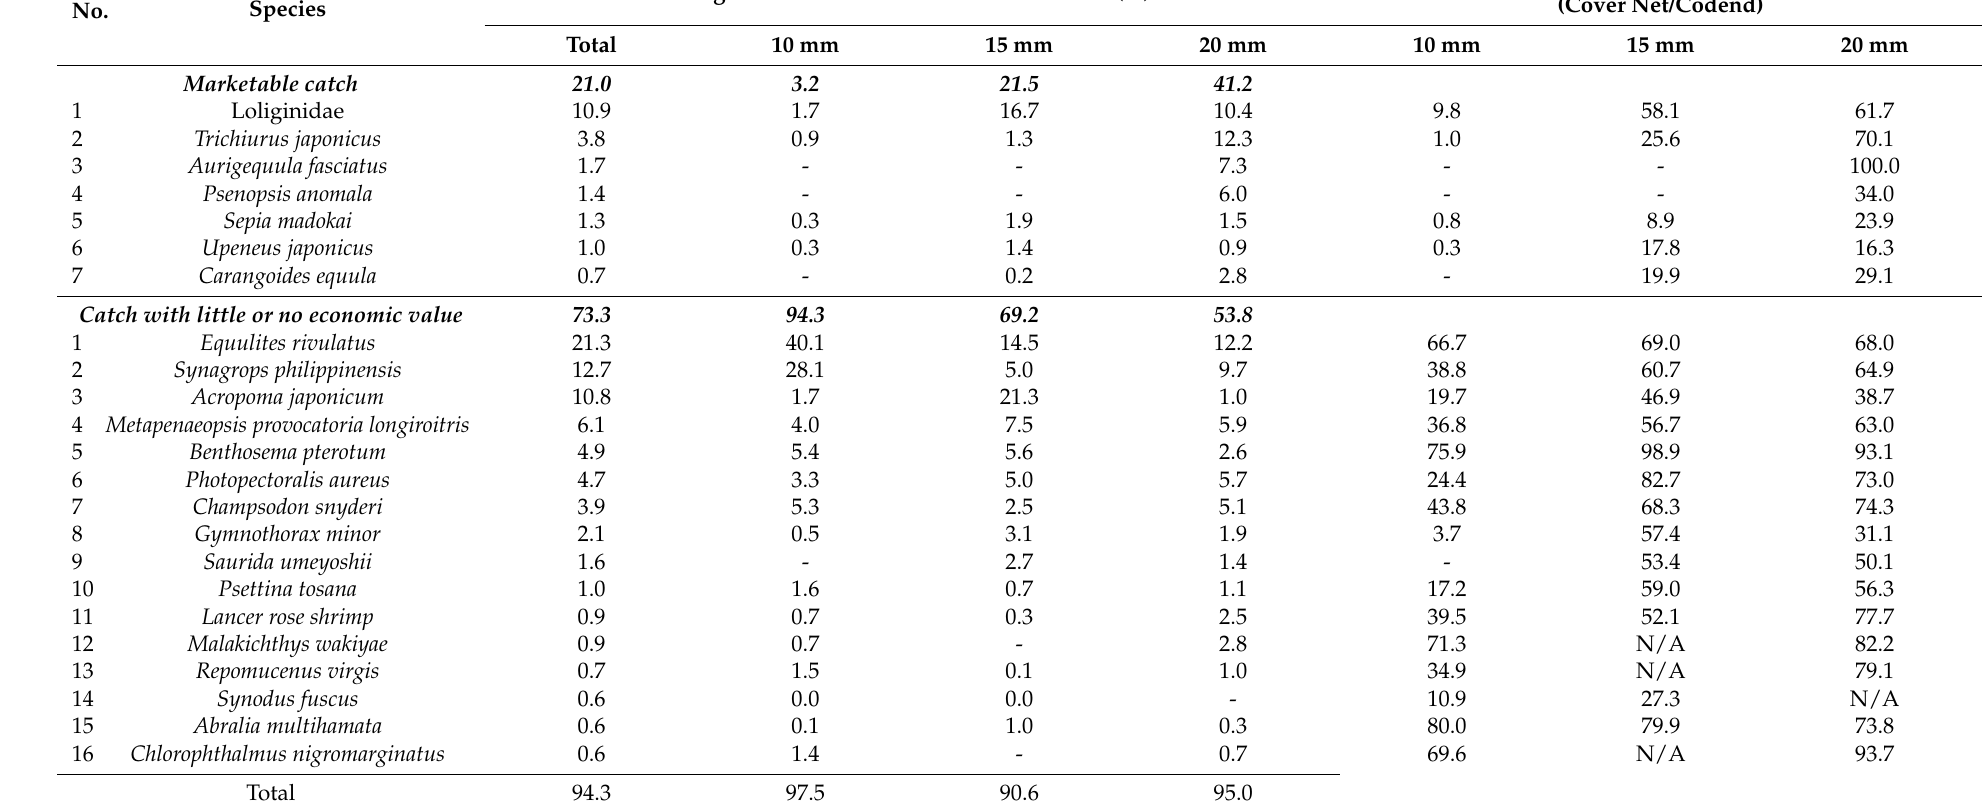
Table 2. Main species of catch excluded by